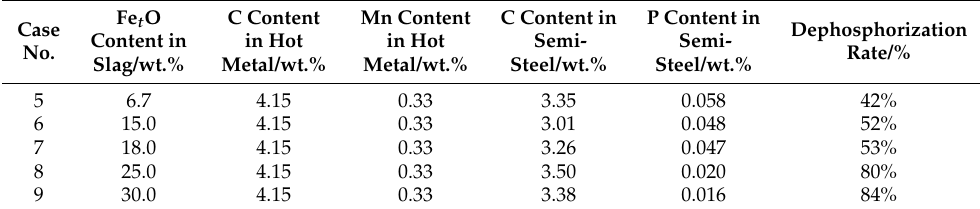
Table 2. The effect of the Fe t O content on the dephosphorization rate.